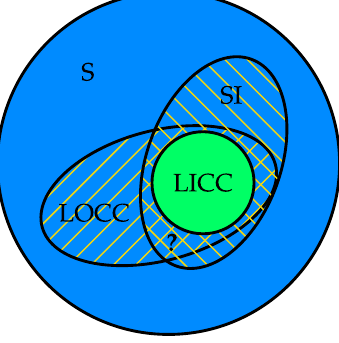
FIG. 1. Hierarchy of LICC, SI, LOCC, and separable oper- ations S. The set of LICC operations is the weakest set, and S is the most powerful set. The crossed region displays operations that are in LOCC and SI, but not in LICC. It remains open if such operations exist. For simplicity, we do not display the sets LQICC and